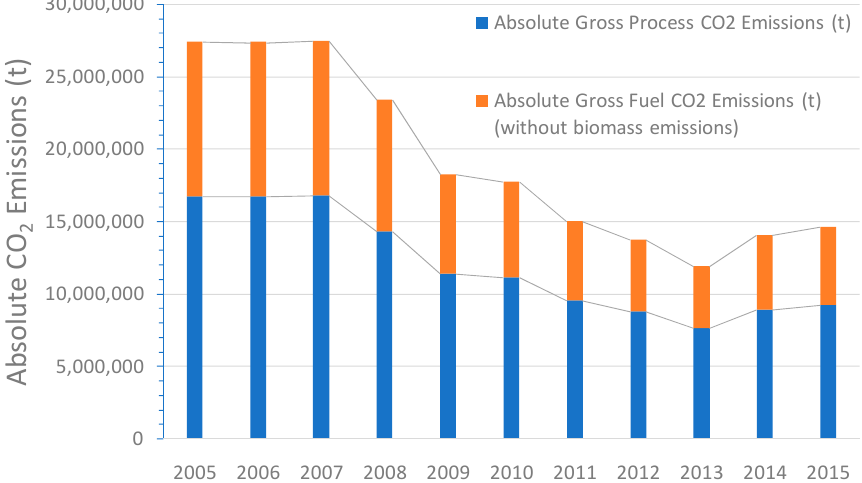
Figure 10. Absolute CO 2 emissions (tons) evolution from 2005 to 2015 for the Spanish clinker production: process emissions (bars in blue); fuel emissions (bars in orange).